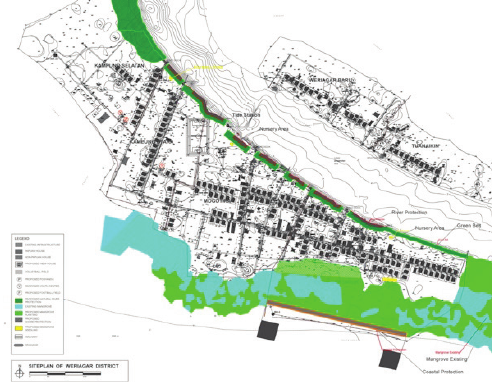
Figure 7. Arrangement pattern of river border and coastal